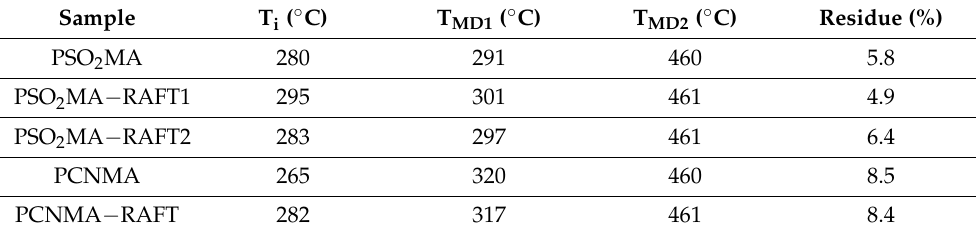
Table 3. Thermal degradation onset (T i ), maximum weight loss rate temperature (T MD ) and residue percentage (R) for PSO 2 MA and PCNMA prepared by RAFT and conventional radical